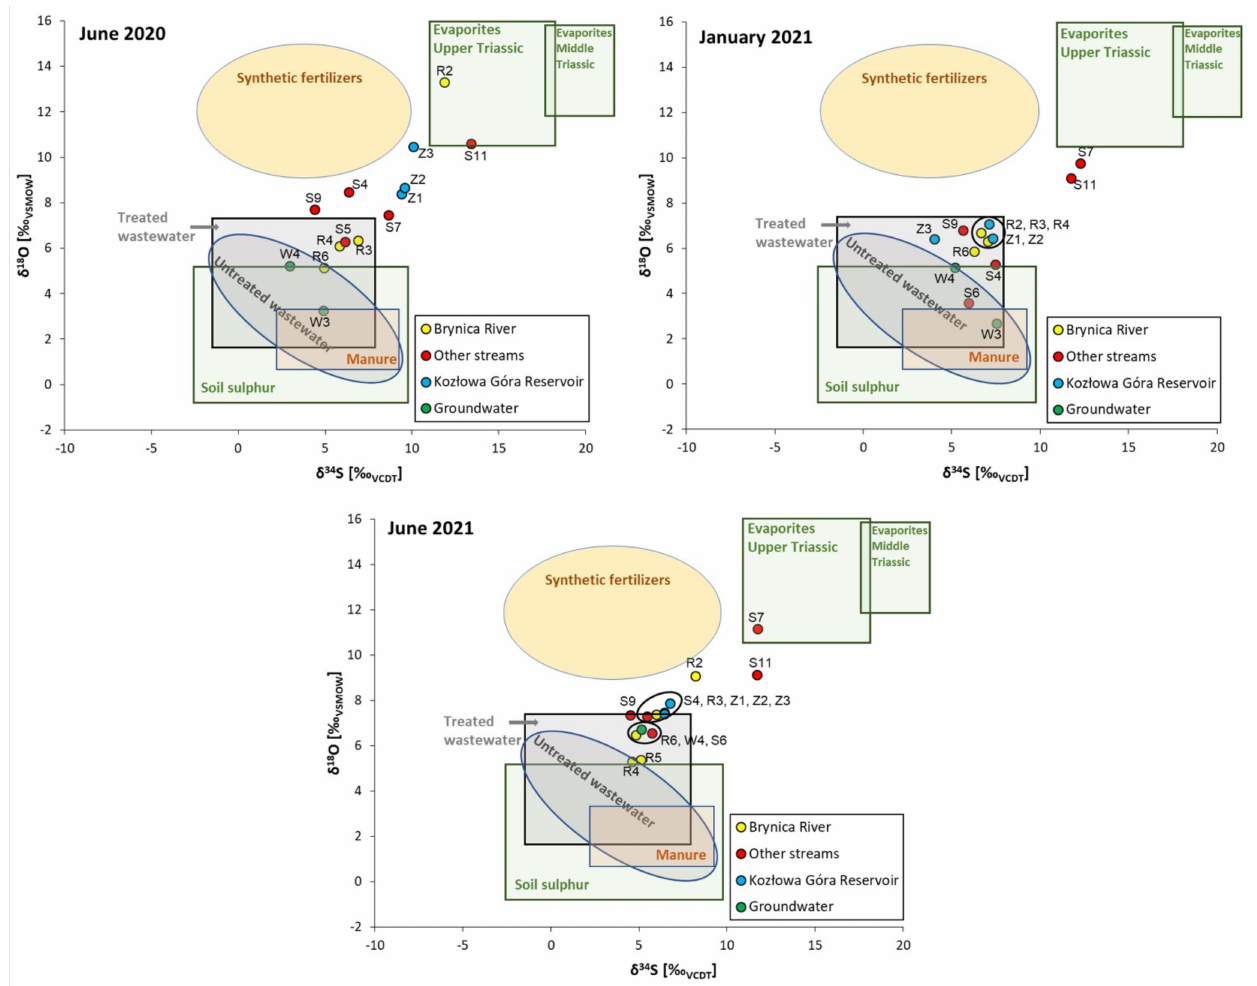
Figure 3. Isotopic composition of sulphate in surface water and groundwater in the catchment area of the Kozłowa G ó ra reservoir sampled in June 2020, January 2021, and June 2021. Coloured boxes represent typical isotopic signatures of different SO 42 − sources [12,26,45–49]. Isotopic signatures of treated and untreated wastewater and synthetic fertilisers are from another study based on local sources